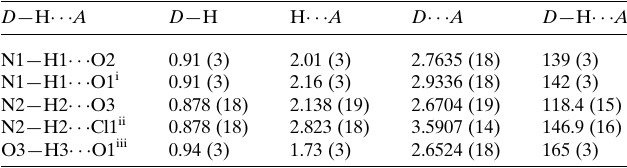
Table 2 Experimental